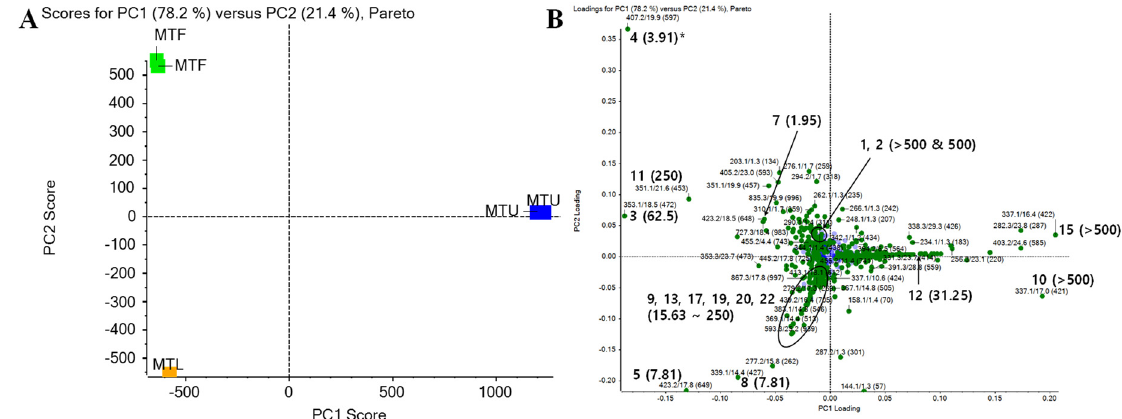
Figure 2. PCA results of extracts of M. tricuspidata leaves (MTL), ripe fruits (MTF), and unripe fruits (MTU). ( A ) Score plot and ( B ) loading plot. * Indication (number) of the loading plot is expressed by compound number (MIC value, μ g/mL).